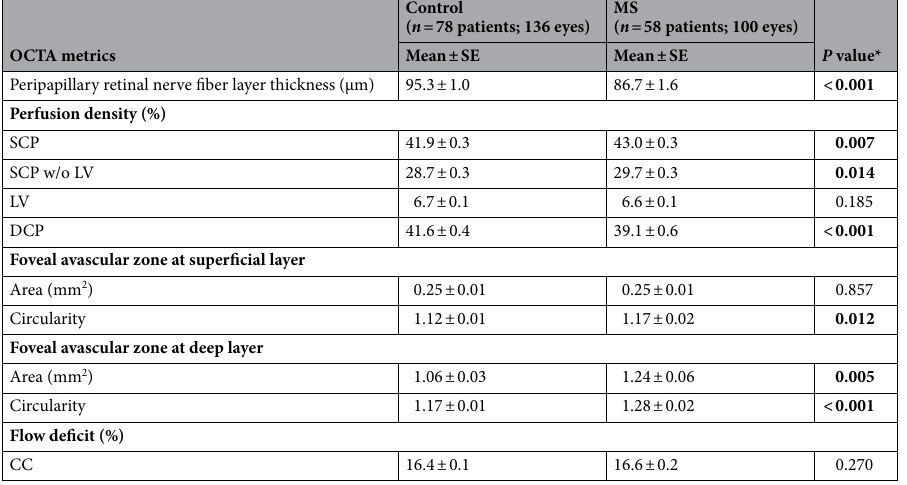
Table 2. Univariate analysis of optical coherence tomography angiography parameters with MS. CC choriocapillaris, DCP deep capillary plexus , LV large vessels, OCTA optical coherence tomography angiography, SCP superficial capillary plexus, SE standard error. Significant values are in bold.